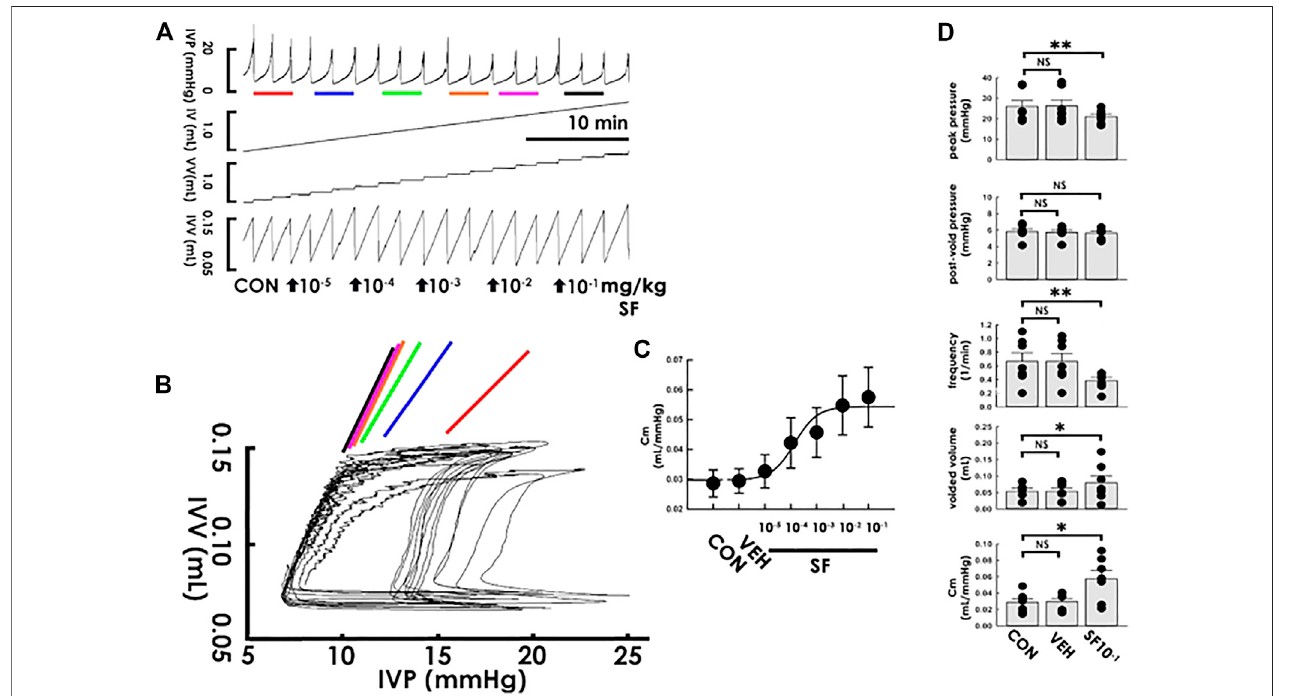
FIGURE 3 | Solifenacin increases bladder compliance. (A) Cystometry before (control; CON) and following intra-arterial solifenacin (SF) injections with increasing concentrations(10 − 5 − 10 − 1 mg/kg,bolus).Red,blue,green,orange,pink,andblackbarsatthebottomofIVPmarkthecyclesdisplayedinthepressure-volumeanalysis. (B) Pressure-volume loops showing increasing concentrations of solifenacin progressively increases the slope of the regression line of the fi lling phase. (C) Dose- response analysis showing solifenacin step-wisely increases the mean compliance (Cm) with an ED50 at about 1.4 × 10 − 4 mg/kg. (D) While vehicle solution (VEH) displays no statistical difference in parameters, injection of solifenacin (1 × 10 − 1 mg/kg; SF1X10 − 1 ) signi fi cantly decreases the peak pressure and voiding frequency but increases voided volume and Cm (* p < 0.05, ** p < 0.01, vs. CON; all n (cid:2) 7). IVP, intra-vesical pressure; IV, infused volume; VV, voided volume; IVV, intra-vesical